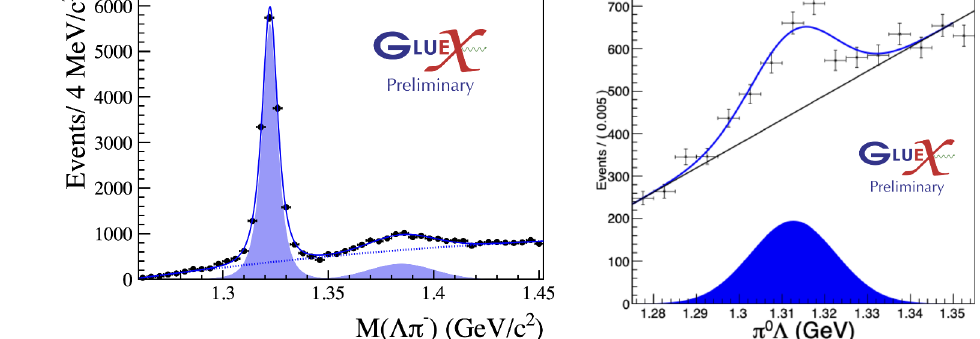
Figure 7. Preliminary invariant mass spectrum of the Λ π − subsystem in the reaction γ p → K + K + Ξ − → K + K + π − Λ → K + K + π − π − p . The Ξ − (1320) can be eas- ily identified as a narrow peak at the expected mass. The bump at higher masses is due to the Σ (1385) with a miss-identified pion.